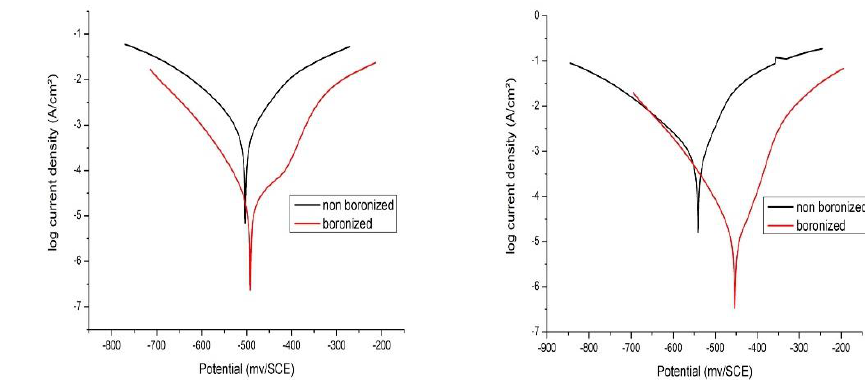
Fig. 4. Tafel curves of API X52 steel before and after boronizing in (a) HCl solution (b) H 2 SO 4 solution.